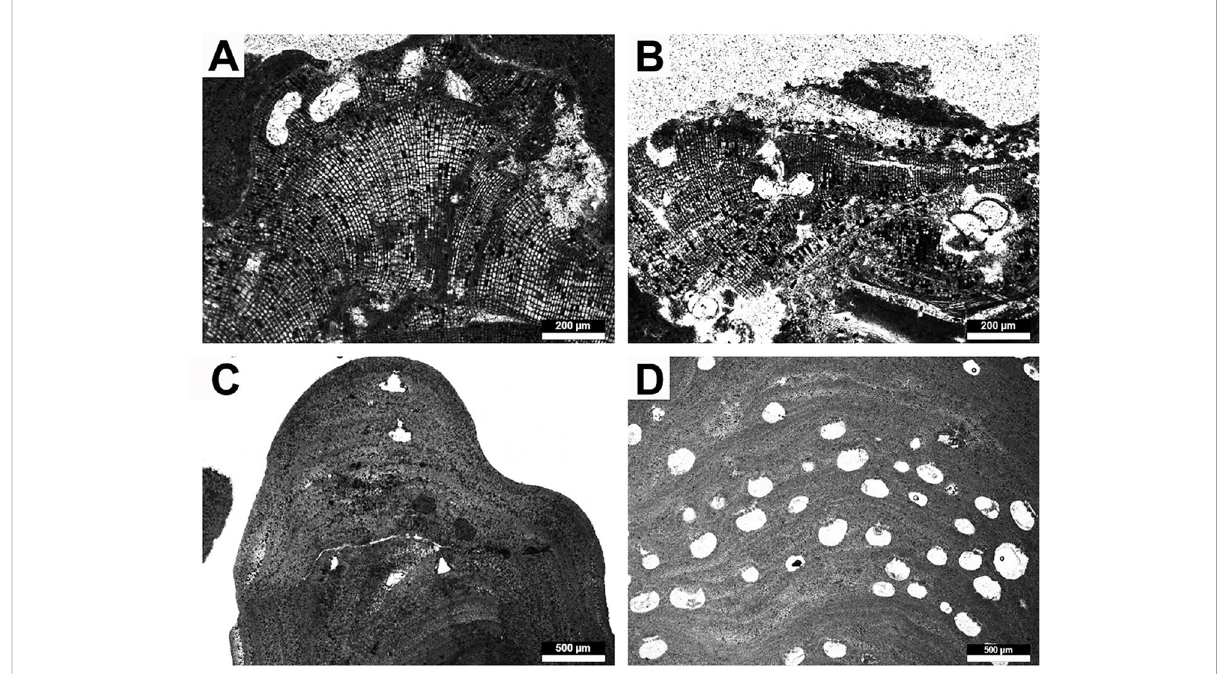
FIGURE 7 Representative rhodolith forming crustose coralline algae. (A, B) Hydrolithon sp., (A) dimerous thallus with uniporate conceptacles, (B) detail of uniporate conceptacle, (C, D) taxa of uncertain generic placement, (C) thallus with uniporate conceptacles, (D) several multiporate conceptacles dispersed throughout the